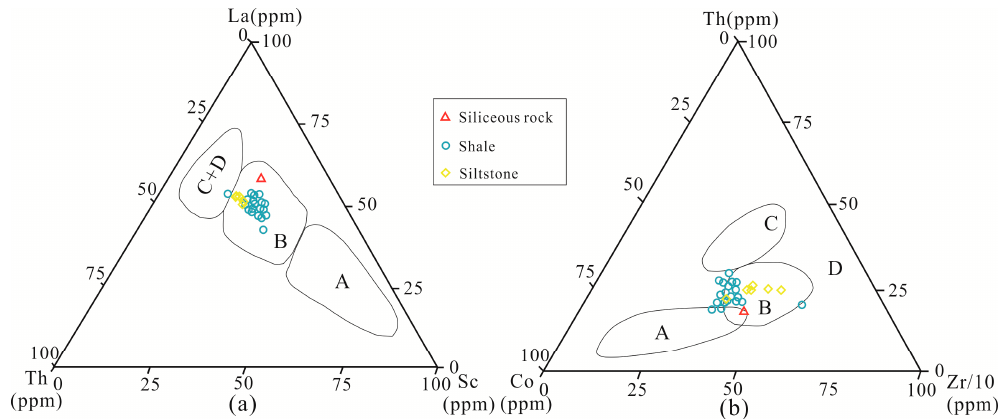
Figure 11. Tectonic setting discrimination diagrams of ( a ) La-Th-Sc and ( b ) Th-Co-Zr/10 for the samples from SQ-1. A: Oceanic island arc; B: Continental island arc; C: Active continental margin; D: Passive continental margin. Base map from [35].